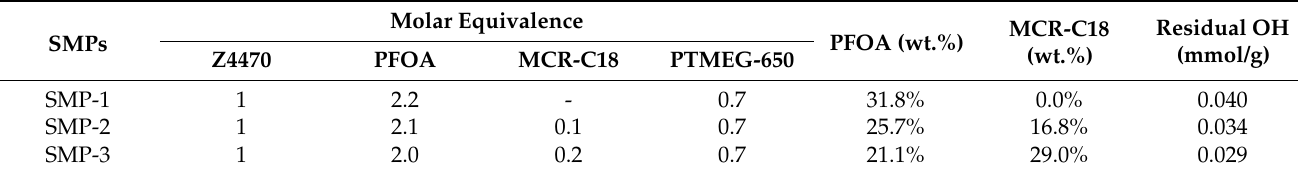
Table 1. Syntheses of